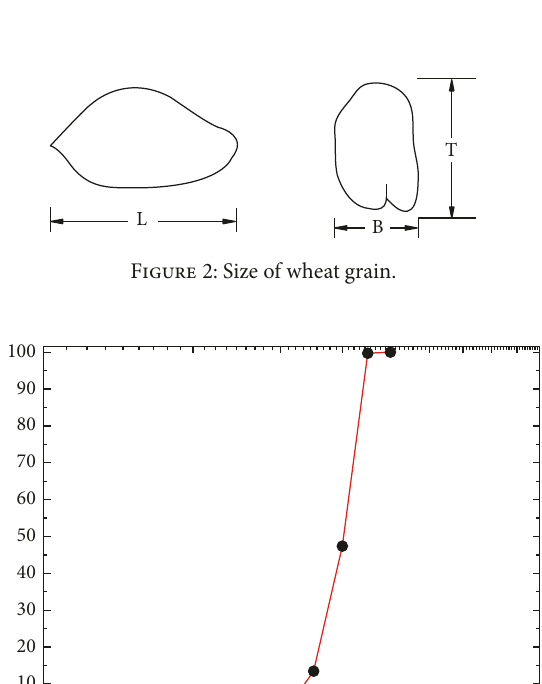
Figure 1: The direct shear box apparatus.